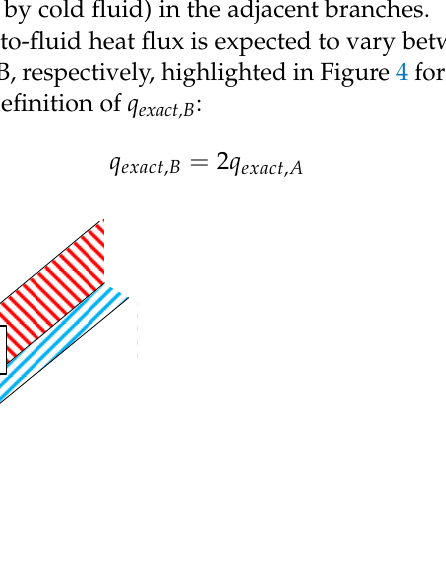
Figure 4. Two surfaces at which q exact is defined for the generic device channel. A: thin wall; B: side wall.